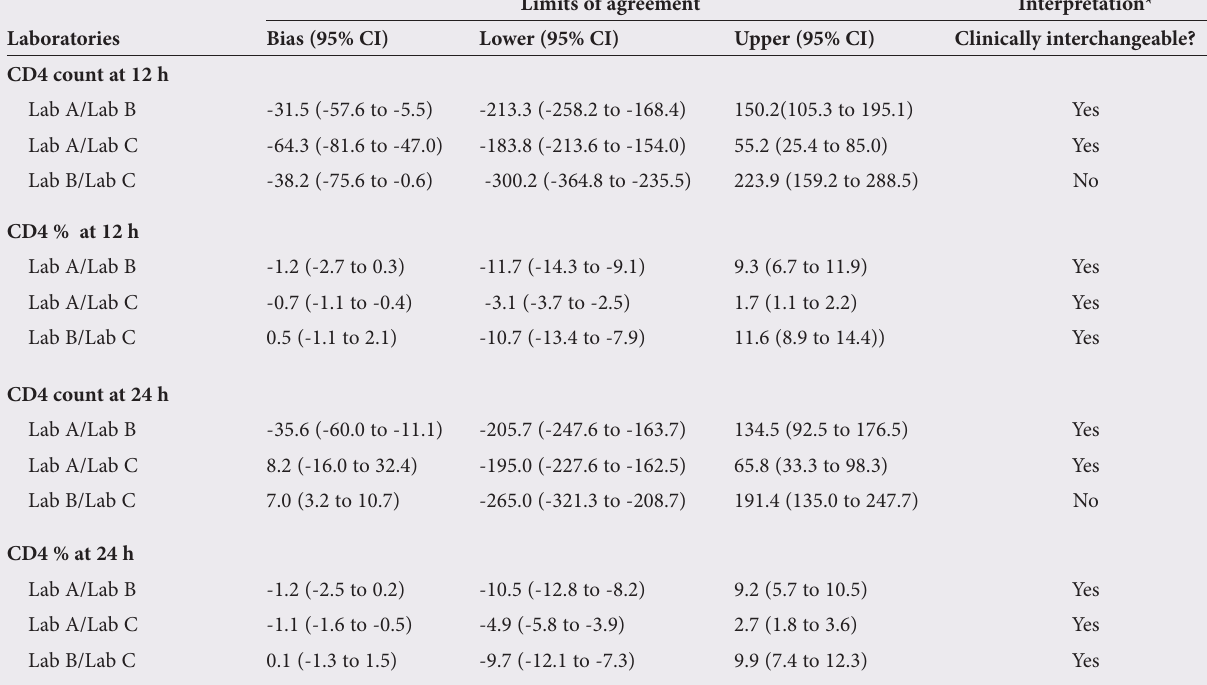
Table 3. Inter-laboratory bias and limits of agreement for CD4 count and CD4 percentage at 12 and 24 hours